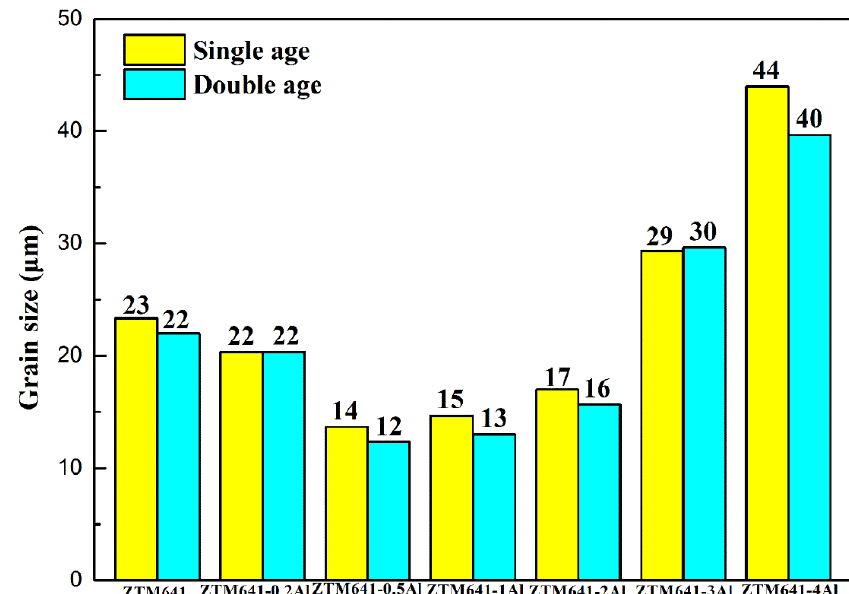
Figure 4. Average grain size of as-aged ZTM641-xAl alloys.